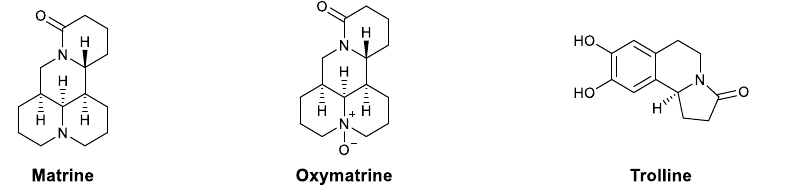
Figure 8. Structures of matrine, oxymatrine, and trolline.